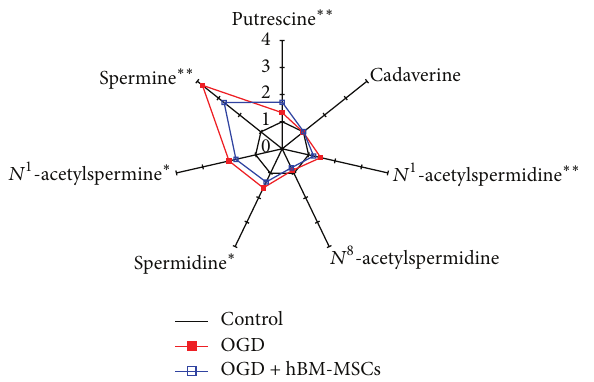
Figure 4: Star symbol plots of OGD and OGD + hBM-MSCsgroups based on the mean levels of the seven polyamines in cultured cells for 72h as the variables after normalization to the corresponding control group mean values. ∗ 𝑝 < 0.05 and ∗∗ 𝑝 < 0.01 (comparison between OGD and OGD + hBM-MSCs groups). Data shown are means ± SE for three independent